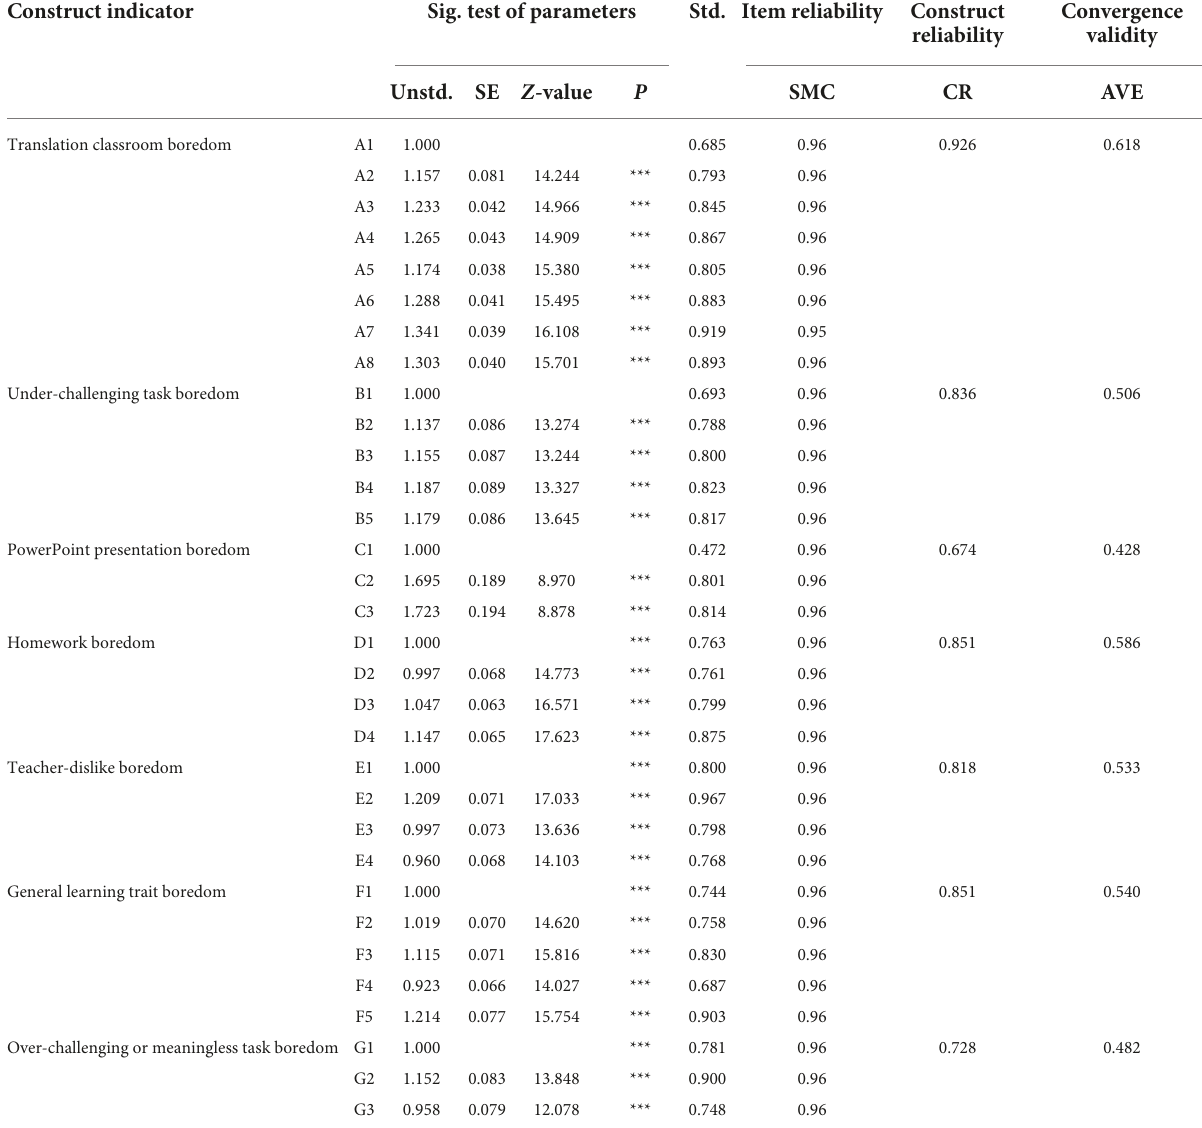
TABLE 2 Analysis of construct reliability and convergence validity.